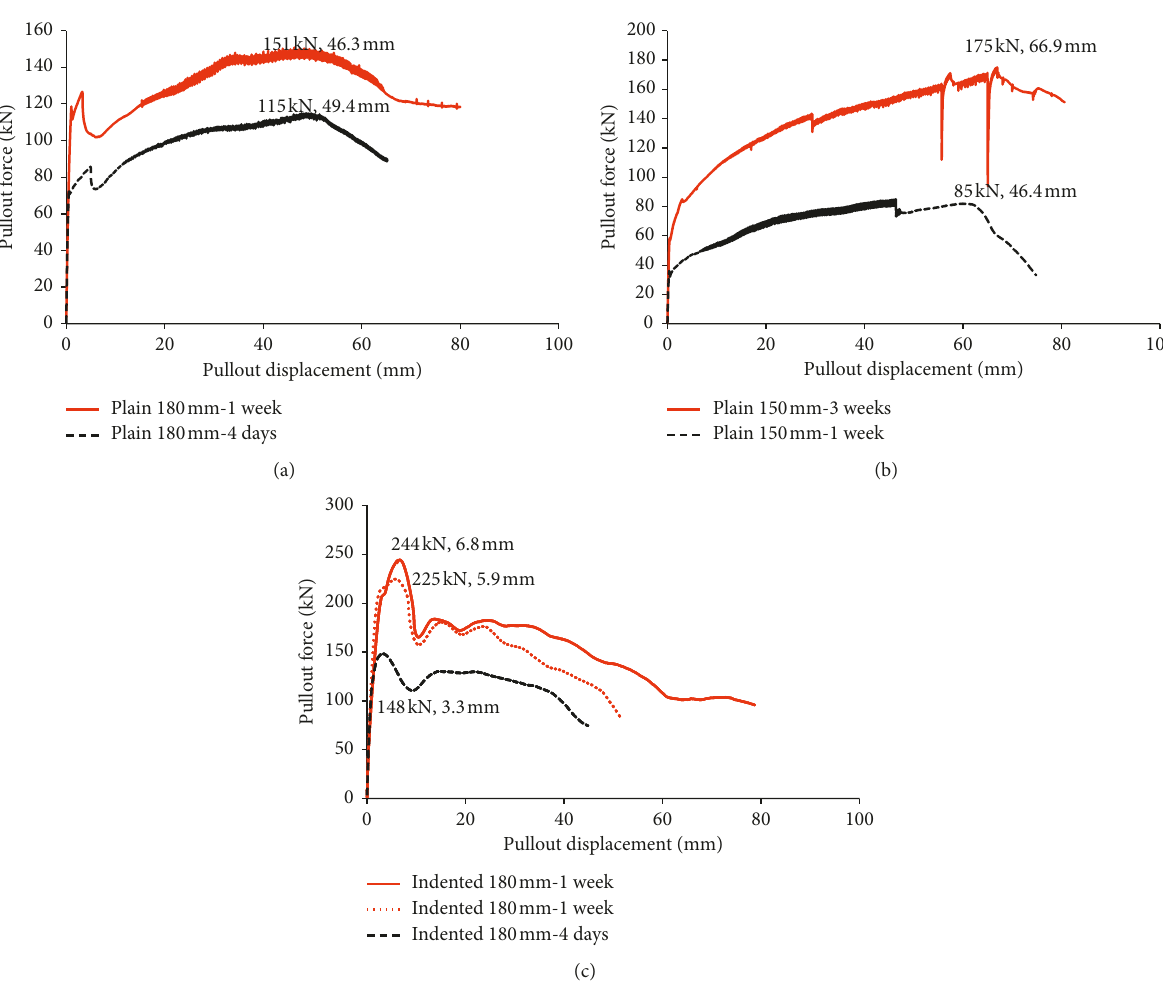
Figure 7: Results of cable bolts tested at different grout ages. (a) Plain cable bolt with 180mm anchorage. (b) Plain cable bolt with 150mm anchorage. (c) Indented cable bolt with 180mm anchorage.